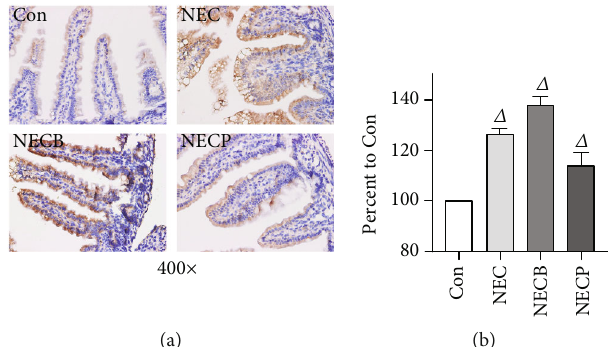
Figure 2: A R expression levels during NEC between groups. (a) A R expression in intestinal tissues was determined by IHC staining 2B 2B (400x). (b) Quantitative changes of A R expression. NEC: necrotizing enterocolitis; NECB: necrotizing enterocolitis+BAY60-6583 2B treatment; NECP: necrotizing enterocolitis+PSB1115 treatment. Δ p < 0 : 05 vs. all other groups.